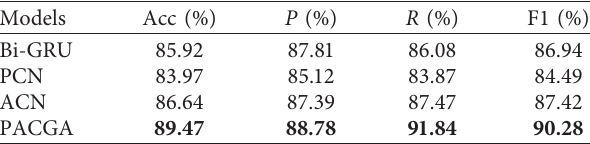
Table 5: Analysis of the PACGA model on Oliners.